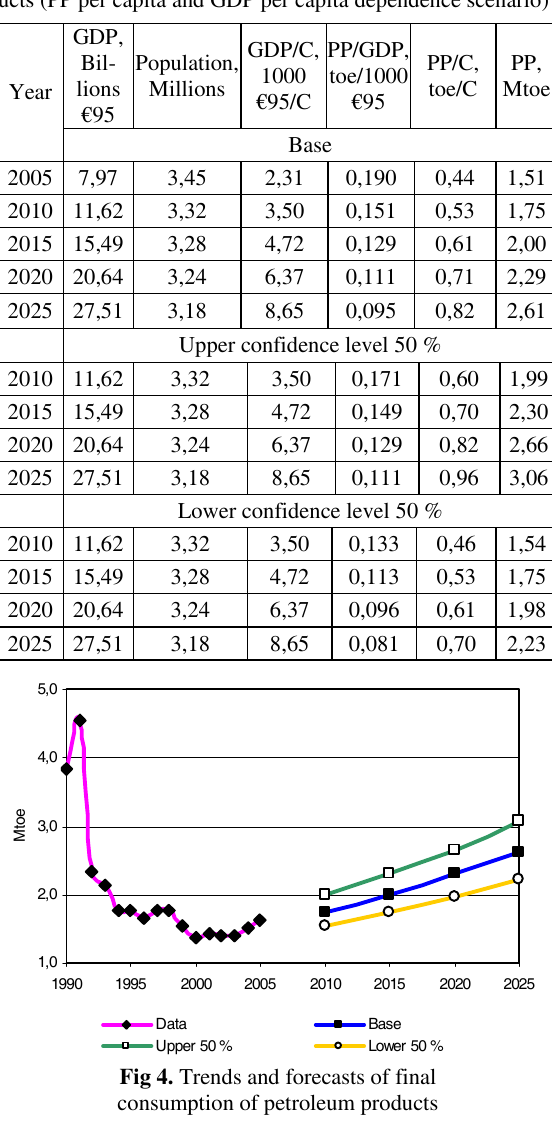
Fig 3. Dependence function of relative consumption of petro- leum products on GDP per capita in different EU countries Table 1. Forecasts of final consumption of petroleum prod- ucts (PP per capita and GDP per capita dependence scenario)